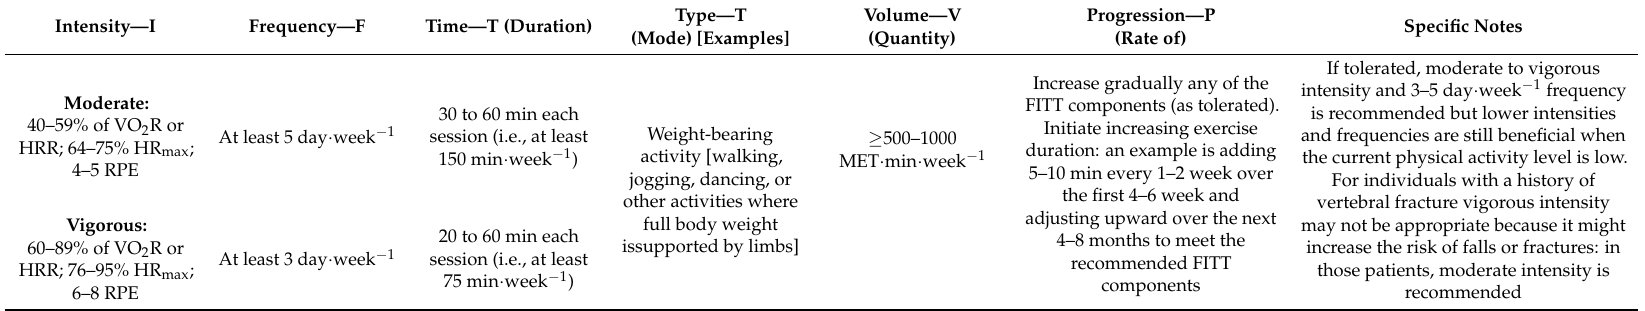
Table 1. Aerobic (cardiorespiratory endurance) exercise recommendations for ageing postmenopausal women.